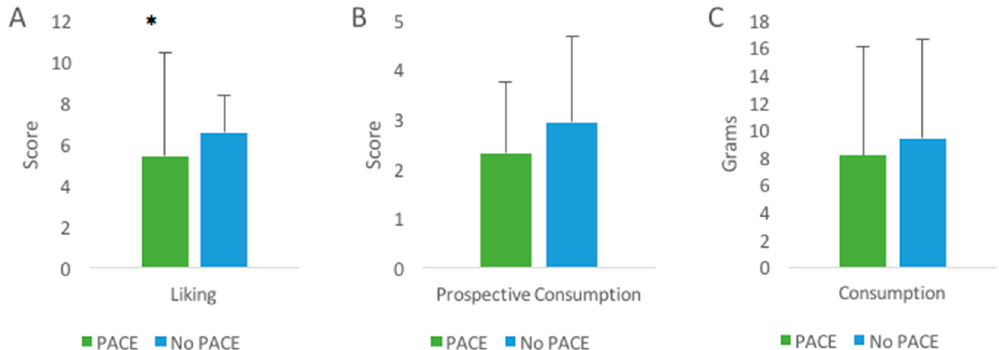
Figure 3. The impact of a PACE label on health focused participants. The PACE label decreased liking in more health focused participants significantly ( p = 0.02) (panel A ). Prospective consumption (panel B (1 = 1 serving = 25 grams, 2 = 2 servings = 50 grams etc.)) and consumption (panel C (consumption was measured in the amount (in grams) that participants sampled)) were not significant. Significant values are displayed: * p < 0.05. Error bars are shown as standard deviation.